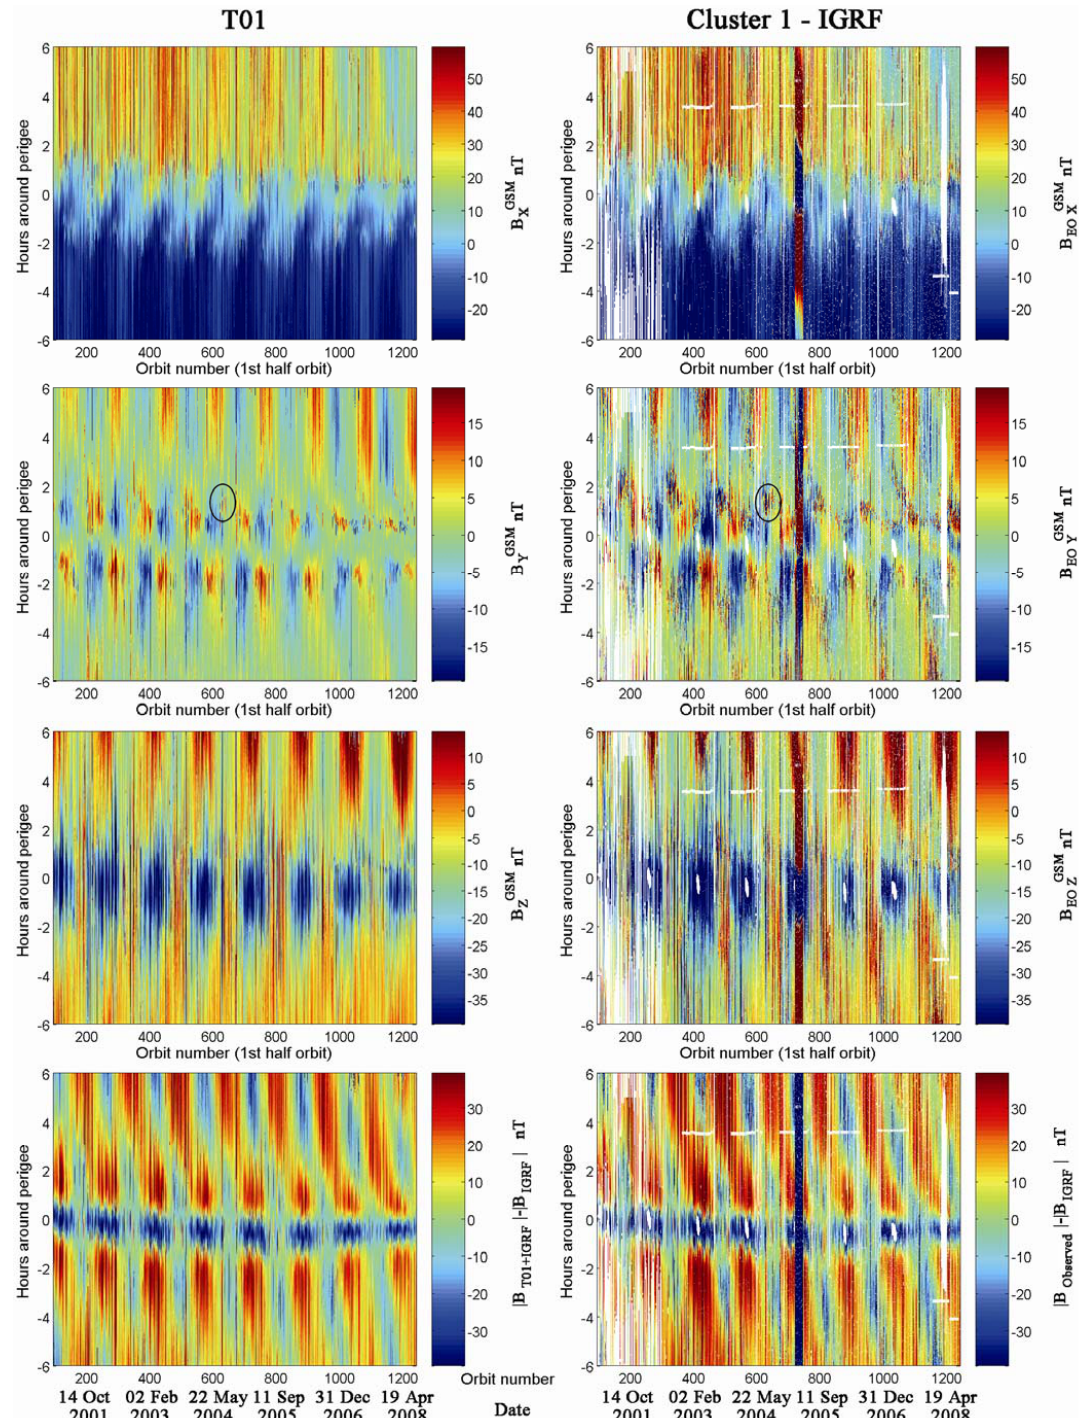
Fig. 3. Plots of the three components and magnitude of external magnetic field predicted by T01 and measured by Cluster S/C 1 (minus IGRF) at the tracks of Cluster S/C 1 for the whole eight years data. Each vertical strip is a section of an orbit – the x-axis is the orbit number, y-axis is time relative to perigee and the colour scale is the value of B XGSM , B YGSM , B ZGSM , and 1B model or 1B observed (each row), for the panels of the left column from T01 and the measured (minus IGRF) for the right